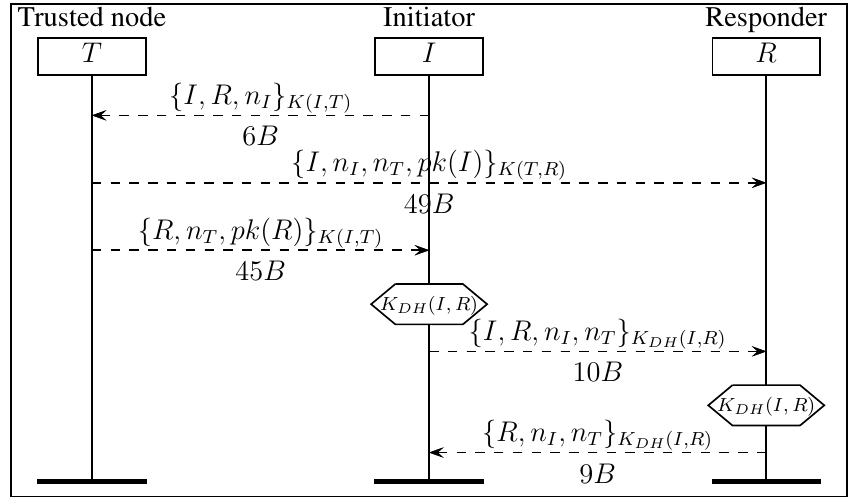
Figure 5. MKE − a : Multi-hop Key Establishment using a trusted node T to deliver public T keys. T possesses pk ( I ) and pk ( R ) . The key K the responder R .